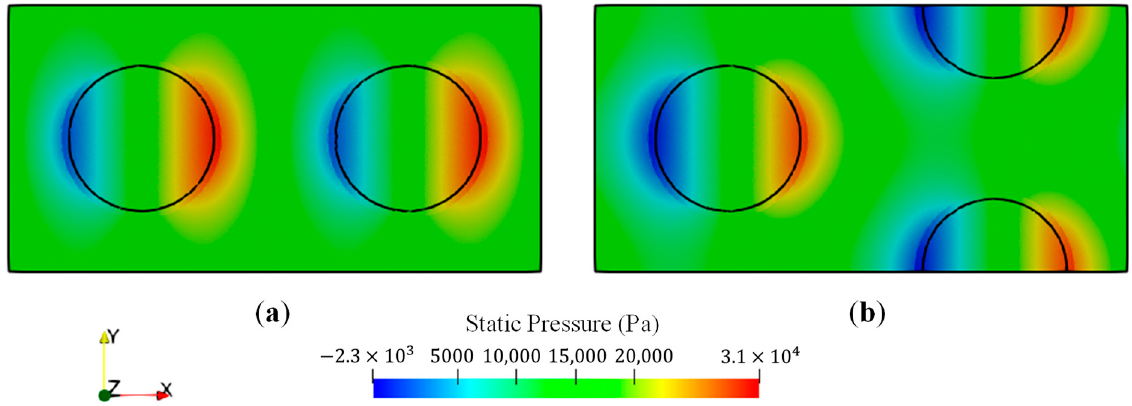
Figure 21. Static pressure distribution on the die surface: ( a ) grid array pattern; ( b ) crossing array pattern. The circle shows where the pockets are approximately located.